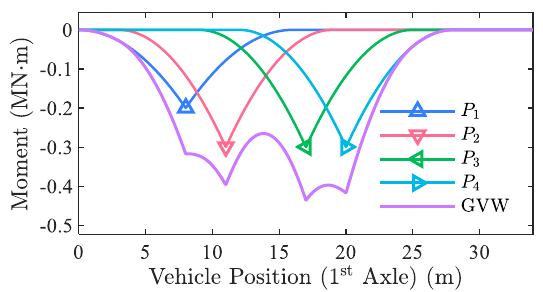
Figure 3. Bridge bending moment of the continuous bridge (4-axle vehicle, GVW = 550 kN).